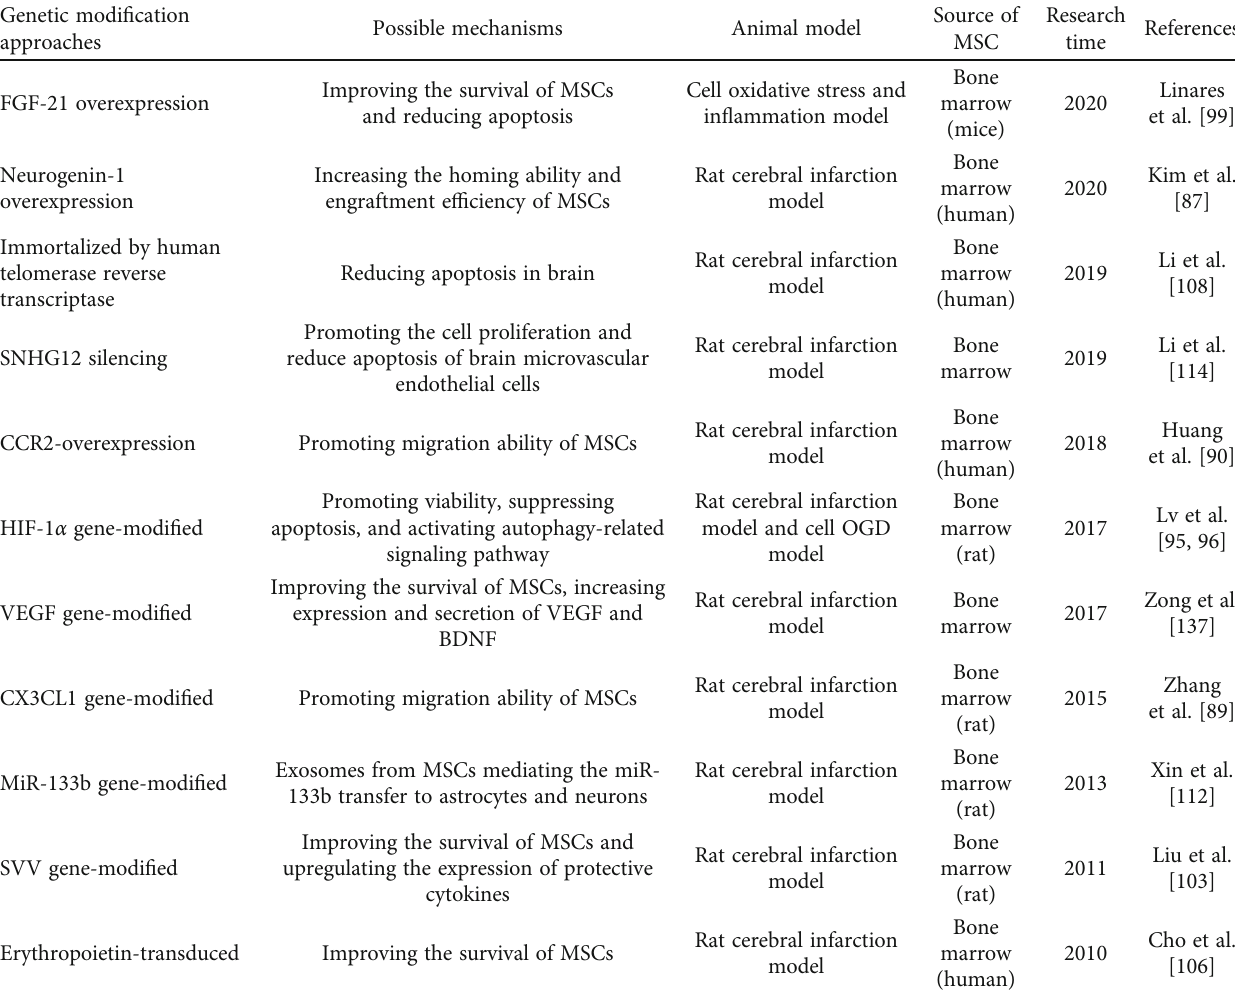
Table 4: Recent studies reporting genetic modi fi cation approaches that can improve the e ffi ciency of MSC transplantation in ischemic stroke